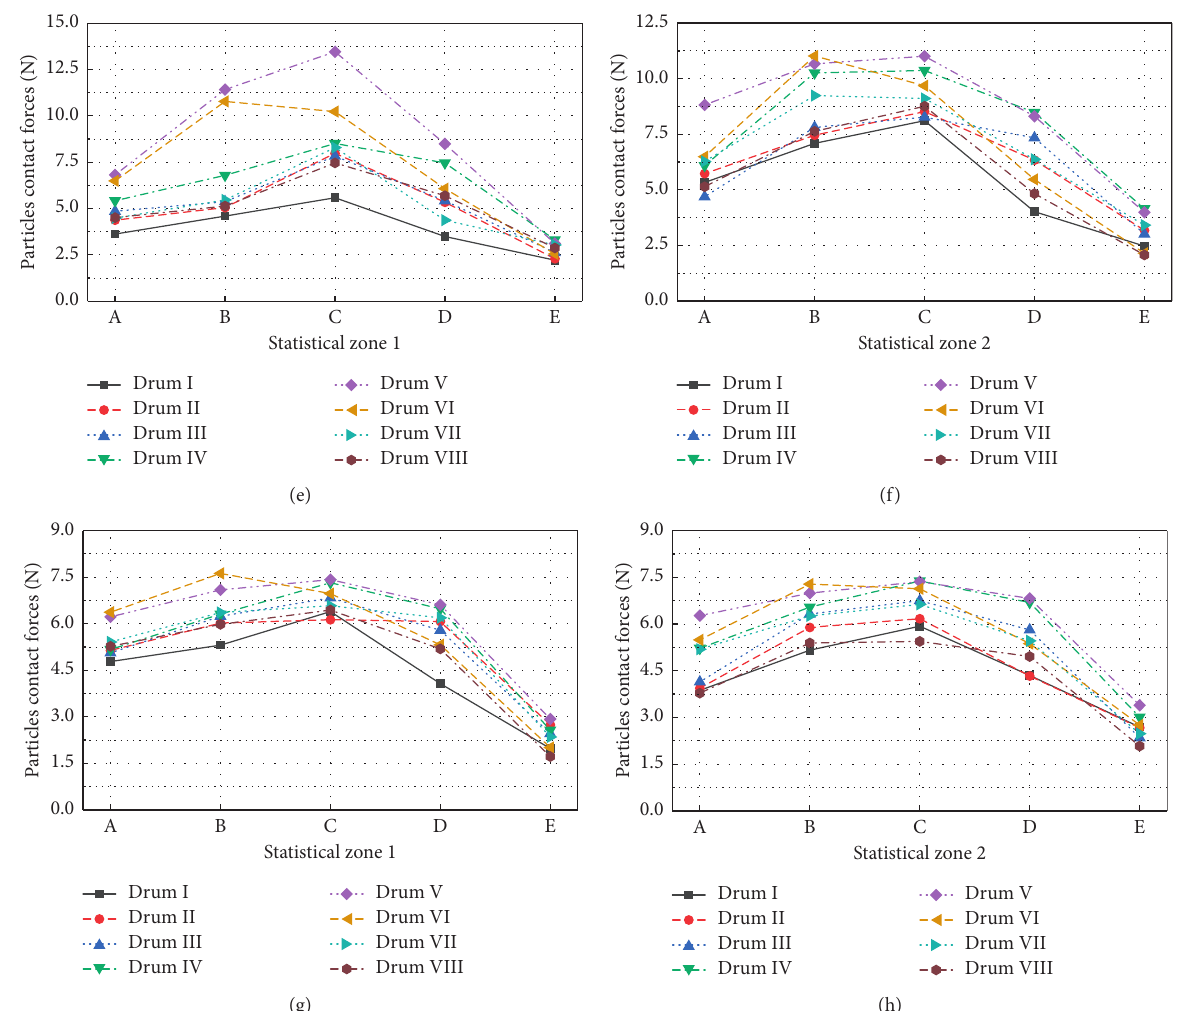
Figure 11: The contact force between particles in different statistical areas with different rotational